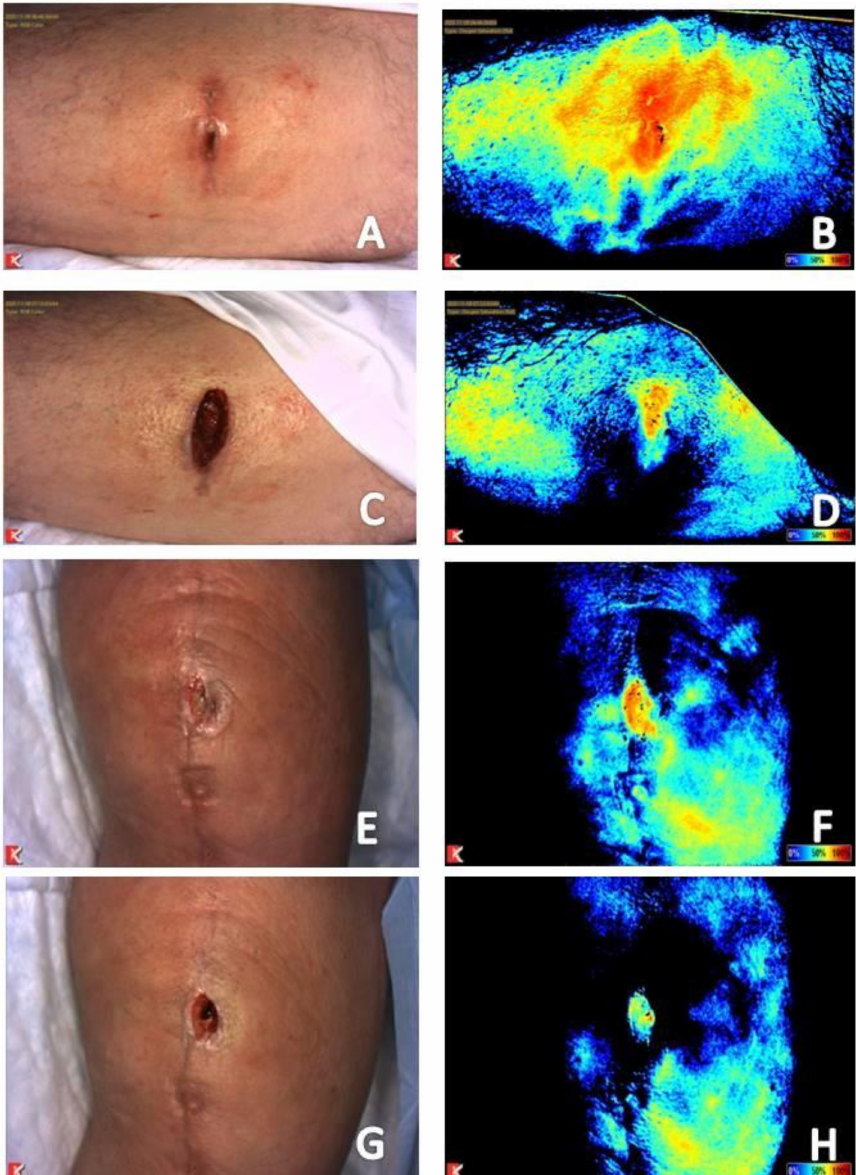
Figure 7. Clinical photograph and near-infrared image assessment of a wound on the abdomen and knee prior to ( A , B , E , F , respectively) and following injection of local anesthetic with epinephrine ( C , D , G , H , respectively) to allow for wound debridement. Note reduction in signal within the periwound area within maintenance of signal within the wound bed consistent with vasoconstric- tion of mature vessels in the periphery of the wound secondary to medication administered and redistribution to less mature vascular in areas where angiogenesis is